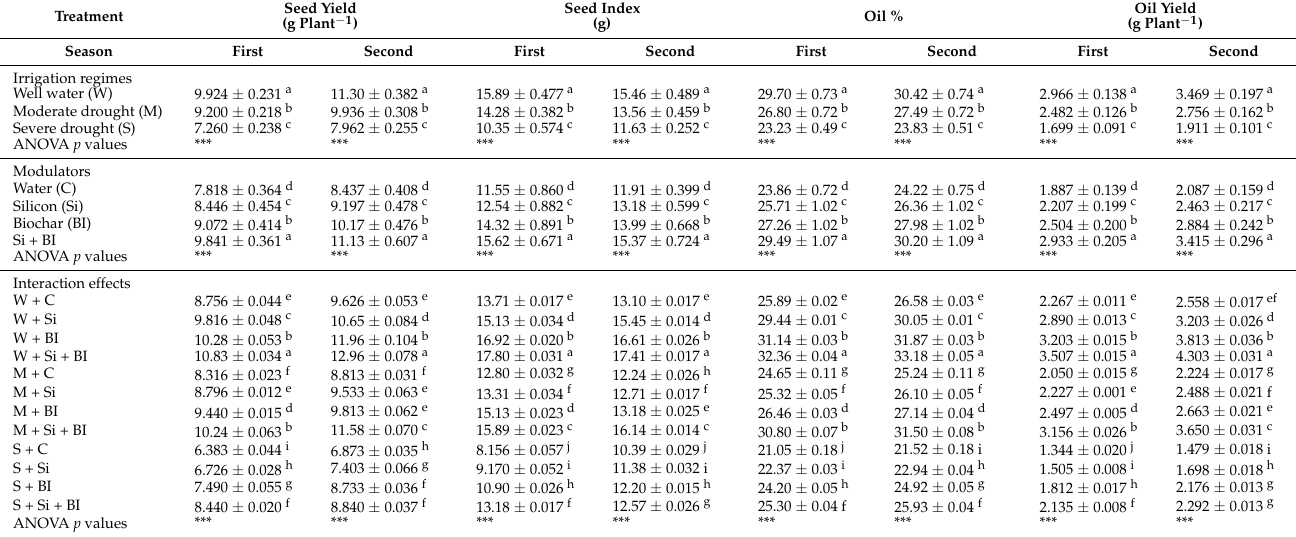
Table 8. Effect of irrigation regimes, silicon, biochar and their interaction on borage plant yield throughout two experimental